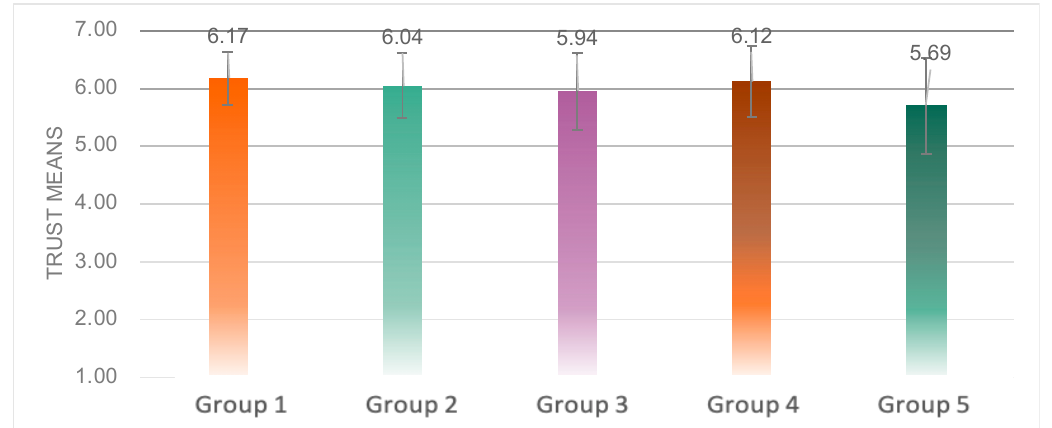
Figure 16. Average value of trust score of the five groups.